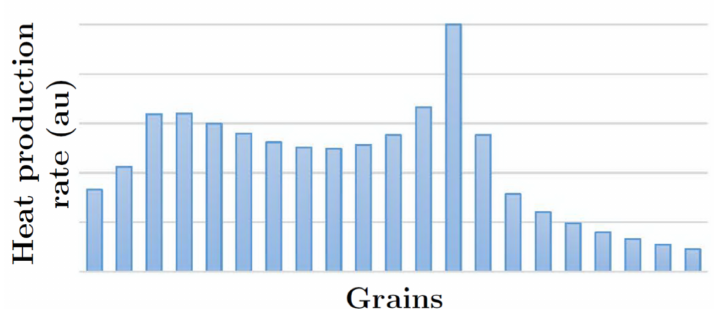
Figure 37. Heat production rate inside the grains in the central line. The highest heat production rate corresponds to the grain placed perfectly below the tip as displayed in Figure 36, reprinted figure with permission from [189]. Copyright (2017) by the American Physical